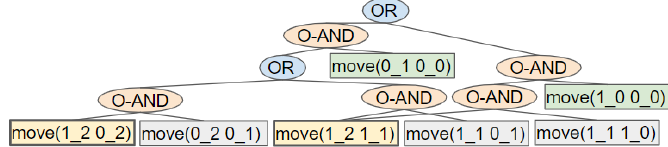
Figure 7. Example of the steps taken to create an Action Graph, when the initial state is (human-at 1_2) and the first goal is (human-at 0_0) . The layout of the environment is shown in Figure 8. Actions which result in the goal state being reached are highlighted in green; yellow boxes with a thick border indicate actions applicable to the initial state; red indicates actions that are being removed; actions with a dashed border are currently in the BFS queue and the bold actions indicate the action which has just been popped from the queue. Reproduced from our prior work